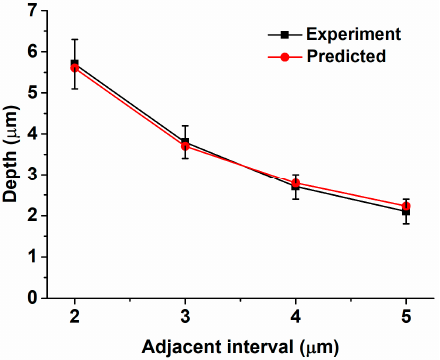
Figure 7. Effect of adjacent interval on machined depth of micro-channels.